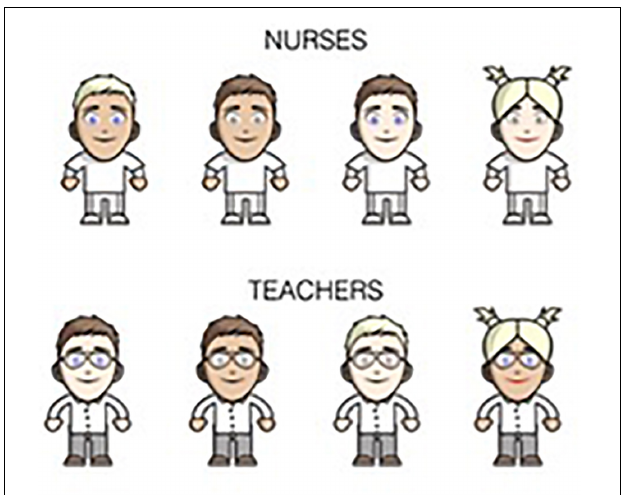
FIGURE 2 | Examples of the avatars used in the